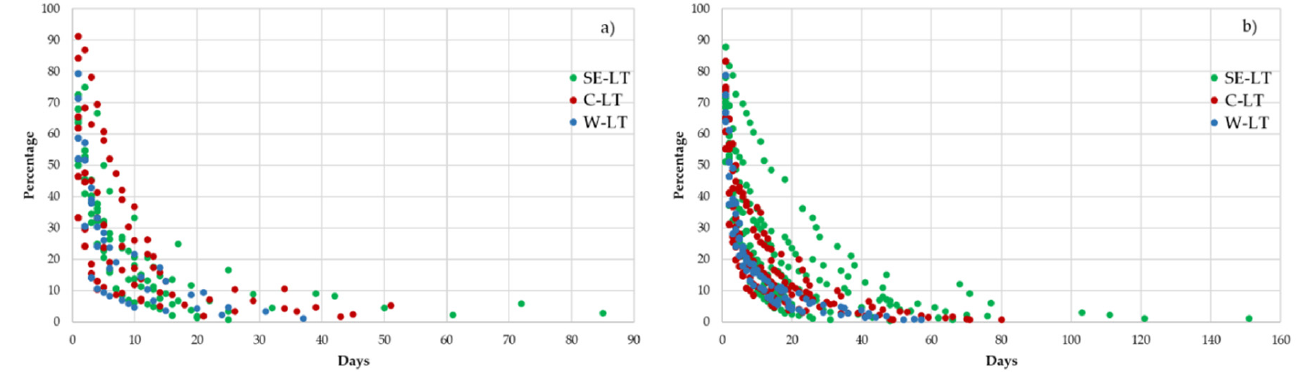
Figure 9. The average number of drought days for the three regions: ( a ) at threshold 30Q95, ( b ) at threshold 30Q80.